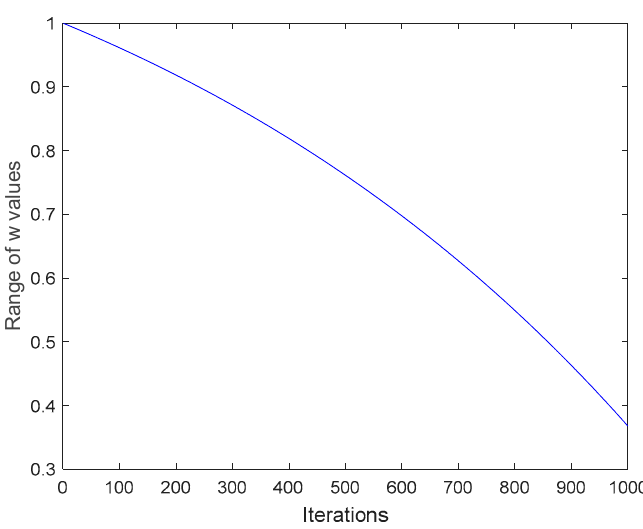
Figure 2. Changes in the location of the finder.